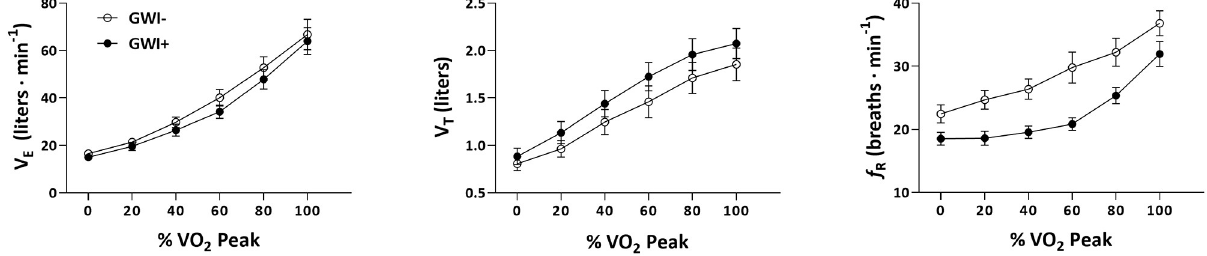
Fig 2. Time course of exercise ventilatory variables ( _ V subgroup (GWI+ = 11, GWI- = 11). Cases (GWI+) and controls (GWI-) are represented in filled and open circles, respectively. Values are mean ± SE.